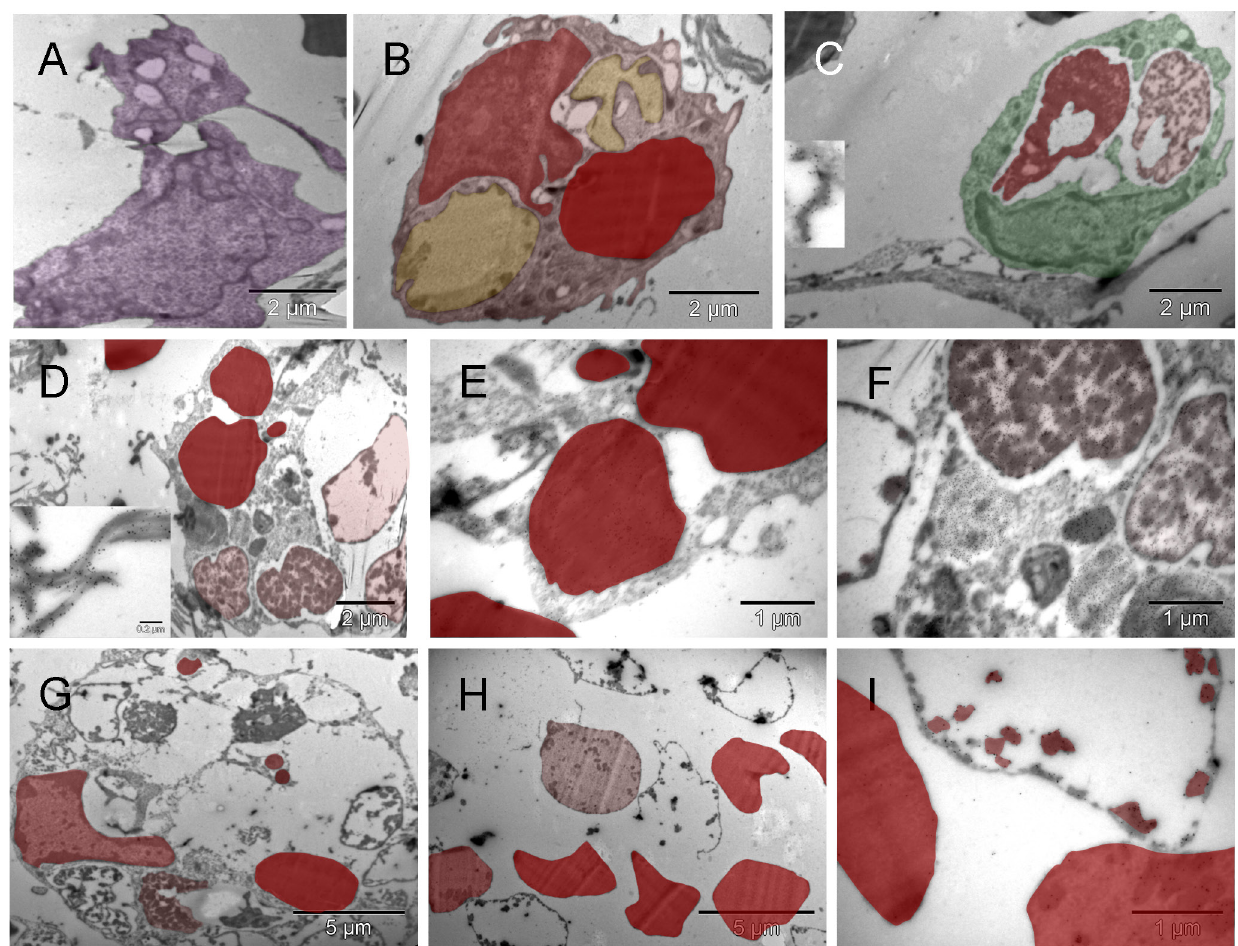
Figure S6. HSCs differentiation by evolution. The cells shown in the upper row [ A , B & C ] were located in the hyaline membrane 5 µm (or less) apart from one another (Figure S14b) suggesting their relatively recent derivation from a common precursor. The first, irregularly shaped cell with platelet-resembling attachment was probably a megakaryocyte (purple) [ A ]. The second one (mixed shades of red), had four large vesicles but only one of them was similar in size and electron density to a cell-free erythrosome (right upper corner in [ A ]), whereas two other vesicles (yellow) were much lighter with the exception of small patches at the periphery, and the fourth one was probably an incompletely converted nucleus [ B ]. The third cell (green) had two large vesicles (red and pink) and both appeared to represent different stages of degradation of the material they were made of [ C ]. The outer membrane of that cell was at one side connected to another cell via calmyrin-containing extracellular fibers (insert in [ C ]). Both cells with the large vesicles made impression of cells with mixed phenotypes with some inclinations to specialize in either producing erythrosomes [ B ] or forming a lumen [ C ]. Fields shown in [ D – I ] were in the same section; they represented what seemed to be left after internal remodeling of polyploidal cells or multi-cellular clusters [ D & G ]. There were cell-free erythrosomes as well as empty vesicles, some broken [ H ]. Clearly, cells were perishing because of such restructuring but they were also changing the microenvironment. Insert in [ D ] shows calmyrin-specific label on fibers of ECM. [ E , F & I ] are enlarged regions from [ D ] and [ H ],